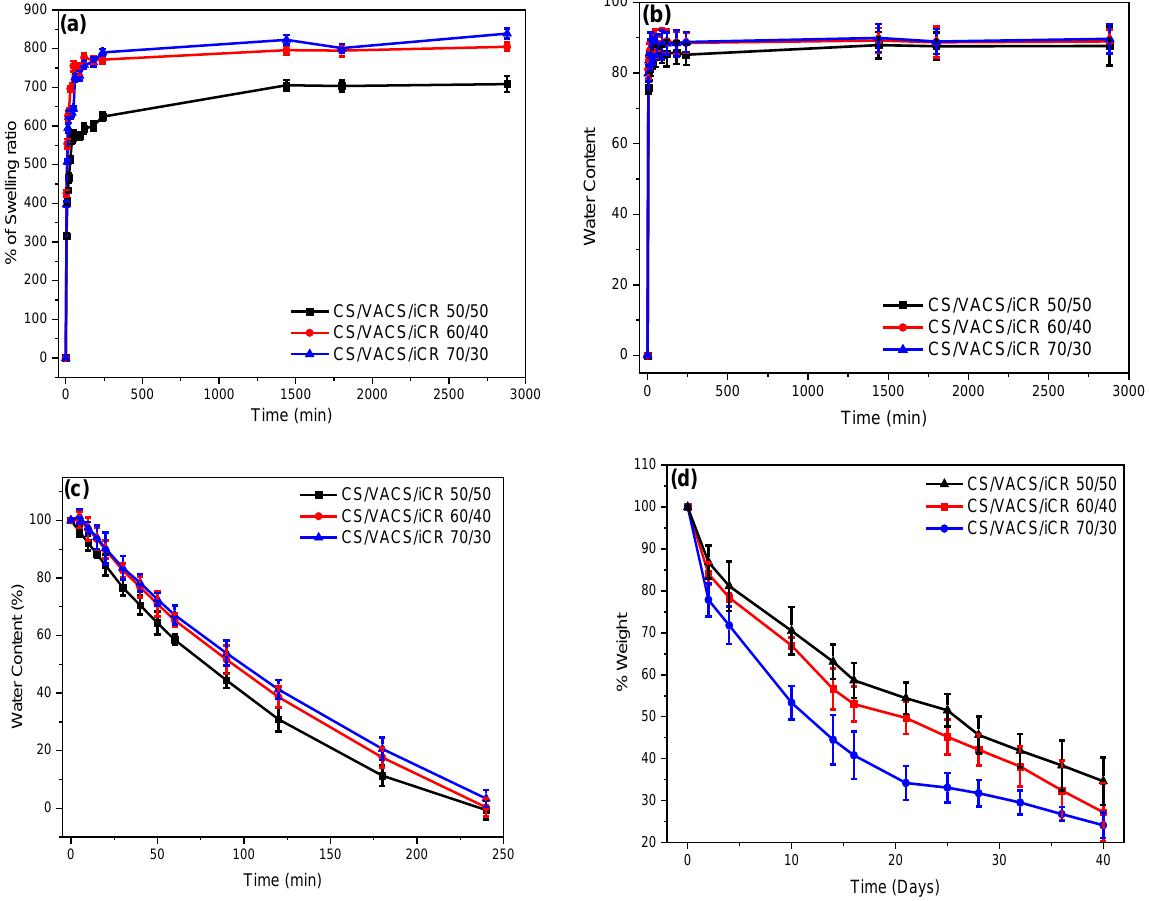
Figure 7. ( a ) Degree of swelling, ( b ) water content, ( c ) dehydration, and ( d ) enzymatic hydrolysis of the samples CS/VACS/iCR 50/50, 60/40, and 70/30 as a function of